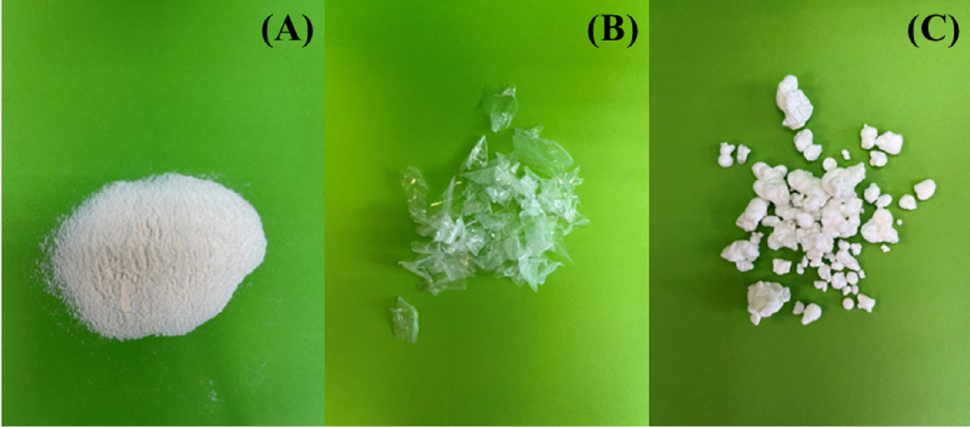
Figure 1. Images for the precursors of Chi-P ( A ), Chi-F ( B ), and Chi-G ( C